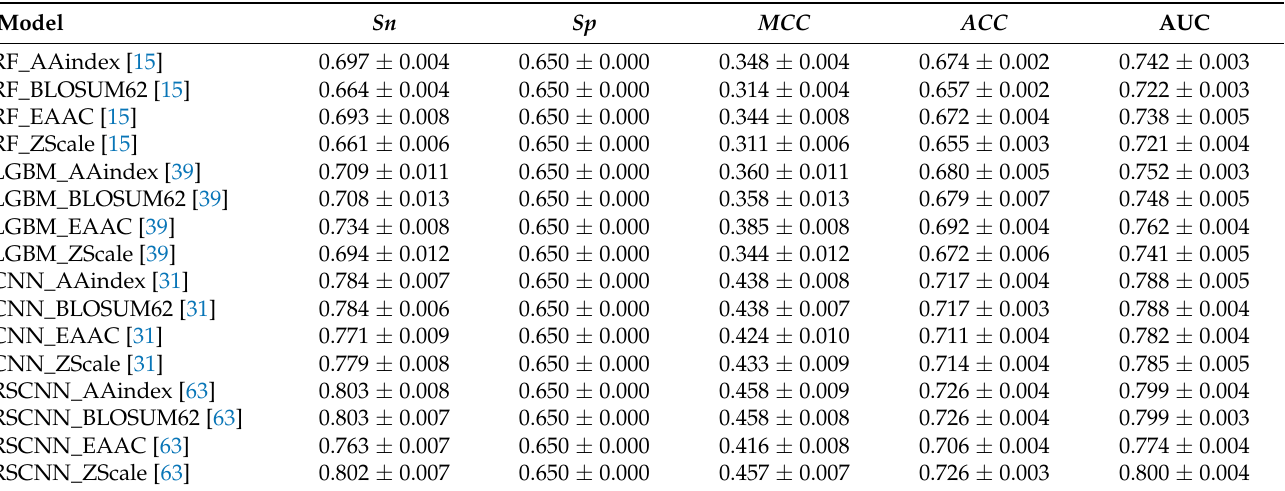
Table 1. Comparison of performance of the different models for prediction of SUMOylation sites based on five-fold cross-validation